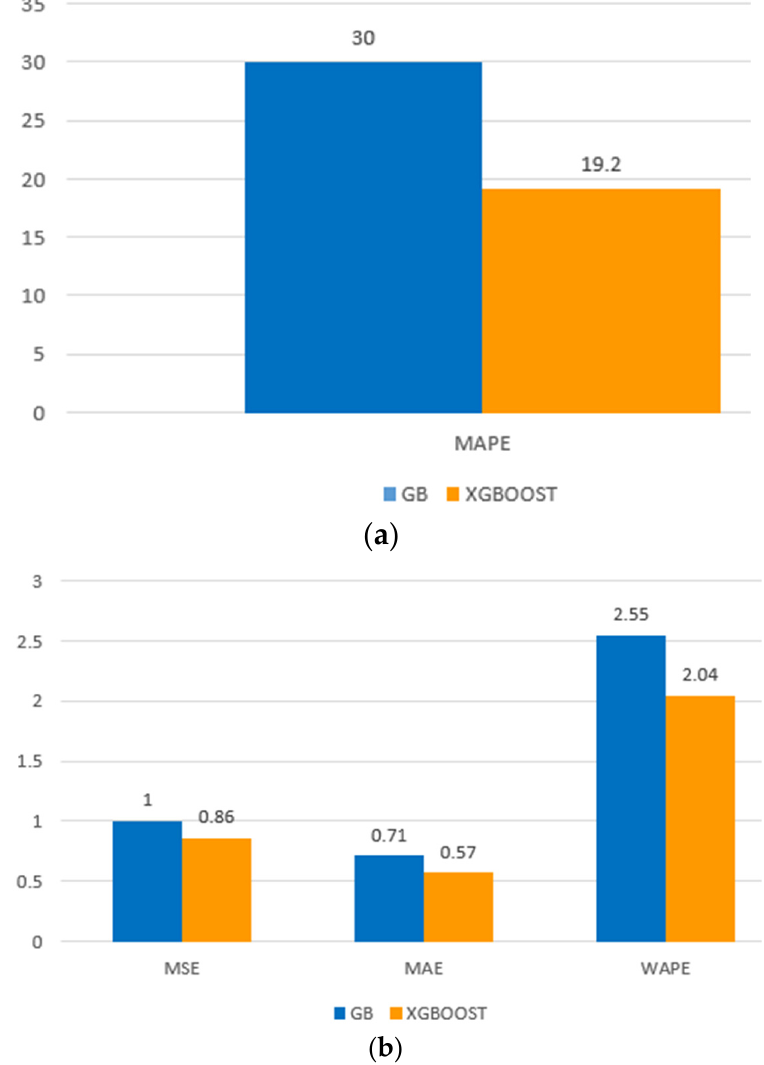
Figure 3. Accuracy metrics referred to the validation test of the GB and XGBoost models: MAPE ( a );